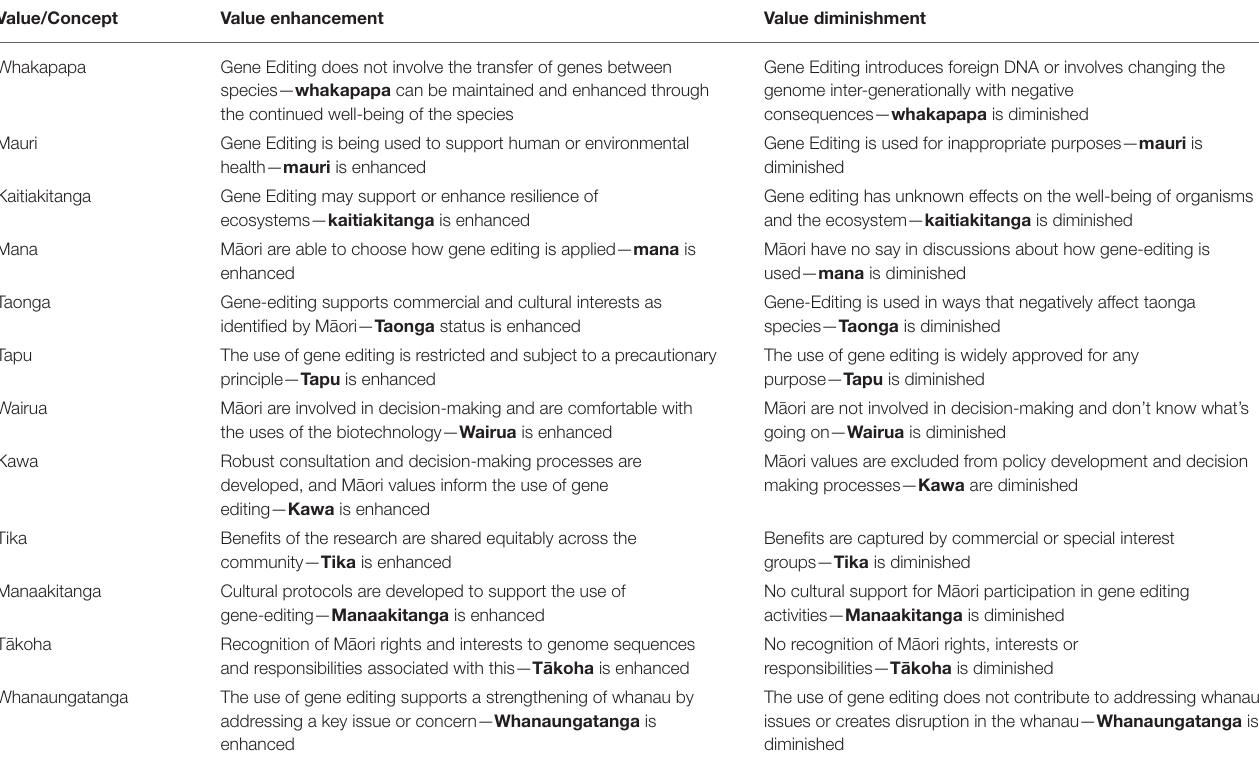
TABLE 2 | Impact of gene editing on M¯aori